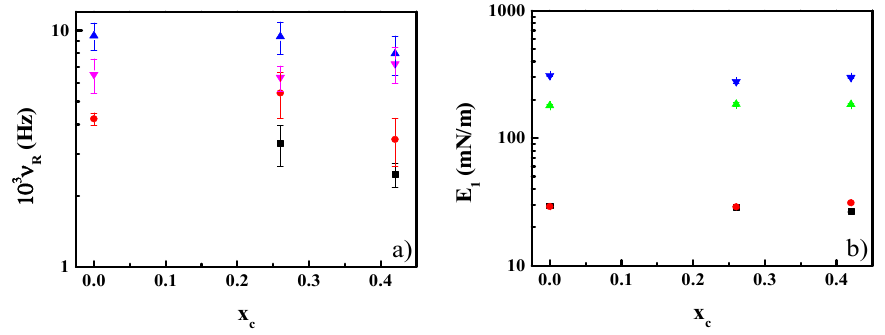
Figure 8. Dependences of ( a ) ν R and ( b ) E 1 on the weight fraction of x CN for different values of the surface pressure Π ( ■ ) 3 mN/m, ( ● ) 7.5 mN/m, ( ▲ ) 20 mN/m and ( ▼ ) 40 mN/m.